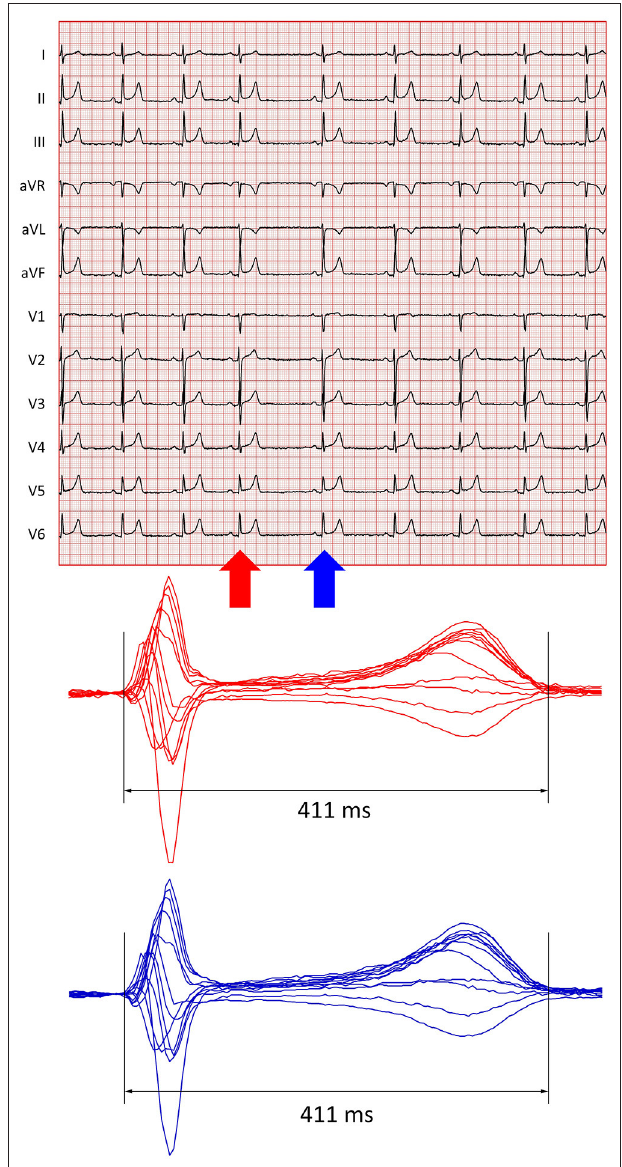
FIGURE 1 | Example of short-term QT/RR relationship. The top panel shows a 10-s electrocardiogram of a 22-year-old healthy female. The recording shows substantial sinus arrhythmia. The shortest and longest RR intervals were 1,019 and 1,528ms, respectively. The red and blue arrows mark QRS complexes preceded by the shortest and longest RR intervals, respectively. The bottom panel shows images of superimposed QRS-T complexes of all the 12 leads of these complexes (in the respective colours). The QT interval measurements ensuring morphological correspondence (Hnatkova et al., 2009) of both complexes led to the same QT interval of 411ms. Thus, relating each of the QT intervals of the tracing to the preceding RR interval (or assuming a substantial immediate beat-to-beat effect of each RR interval on the subsequent QT interval) would have led to substantial inaccuracy (for instance, if these two QT interval measurements are corrected for the preceding RR interval using the Fridericia Formula, a physiologically non-sensical beat-to-beat QTc change of more than 50ms is